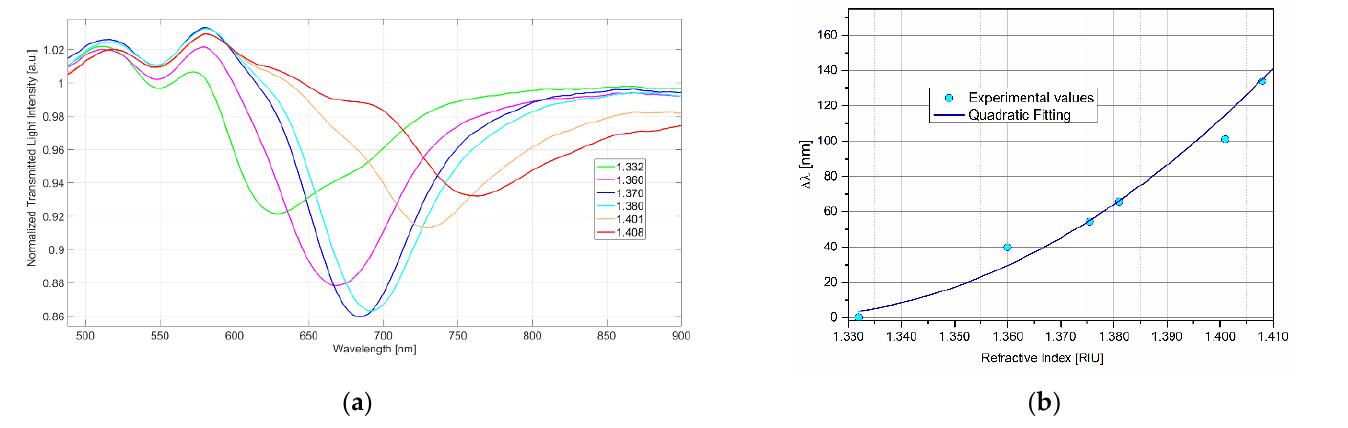
Figure 2. ( a ) Transmission spectra of the MIP-bare platform in water–glycerol solutions with different refractive index (RI). ( b ) Variation of the resonance wavelength with the RI of the overlying liquid.